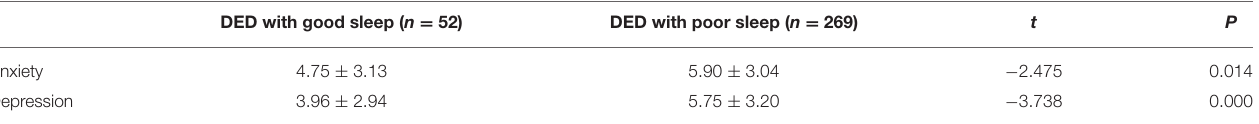
TABLE 2 | Comparison of anxiety and depression in patients with DED with good or poor sleep. DED with good sleep ( n = 52) DED with poor sleep ( n =